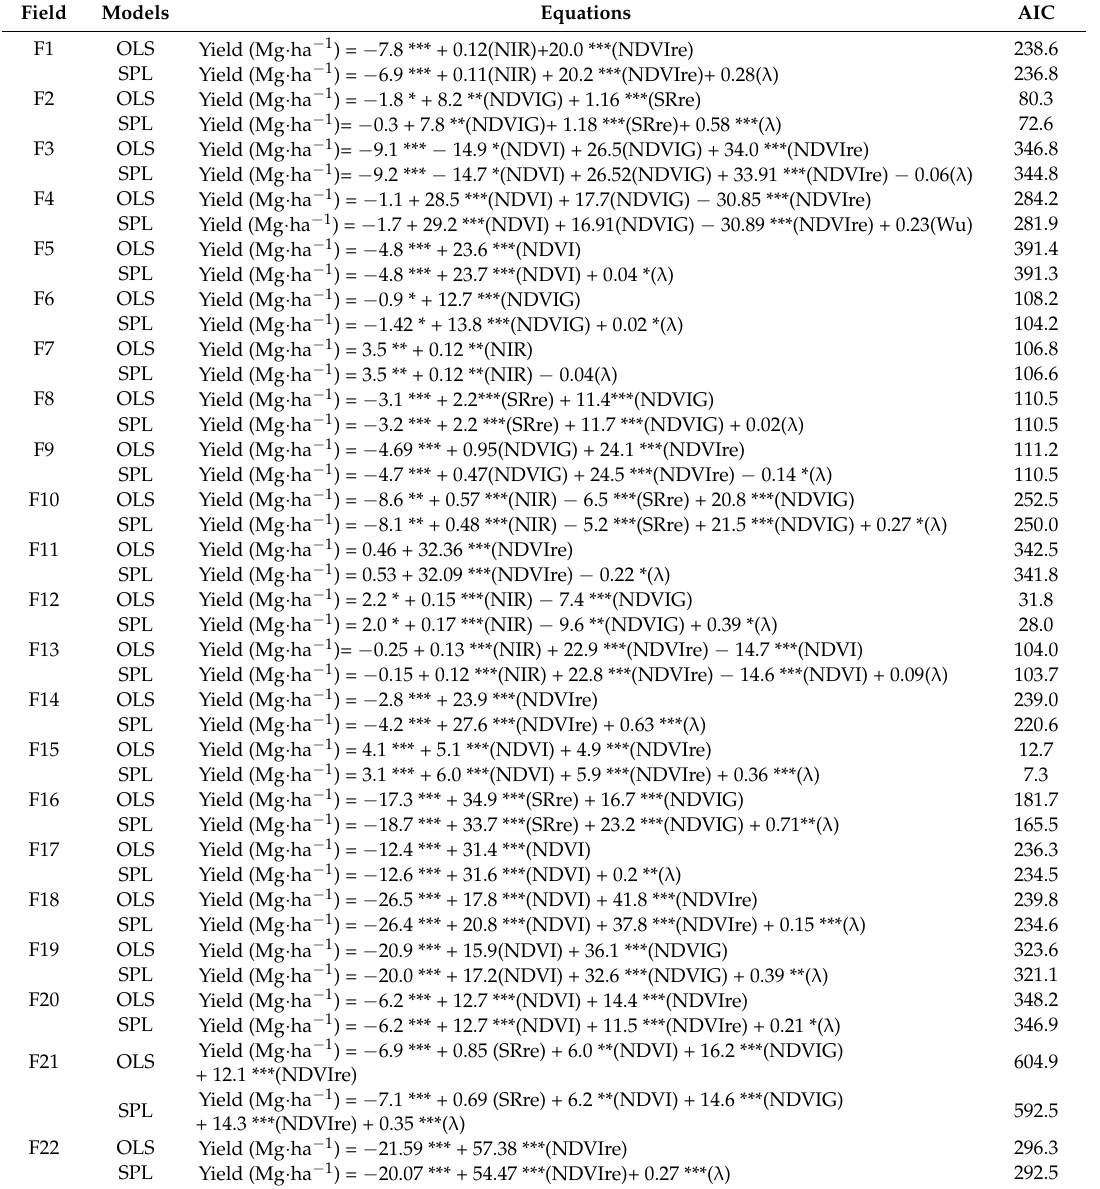
Table 4. Multiple linear regression models (for the ordinary least-square (OLS_ and spatial econometric (SPL)) including the vegetation indices (VIs) obtained from mid-season high-resolution satellite imagery as predictors of the end-season yield monitor